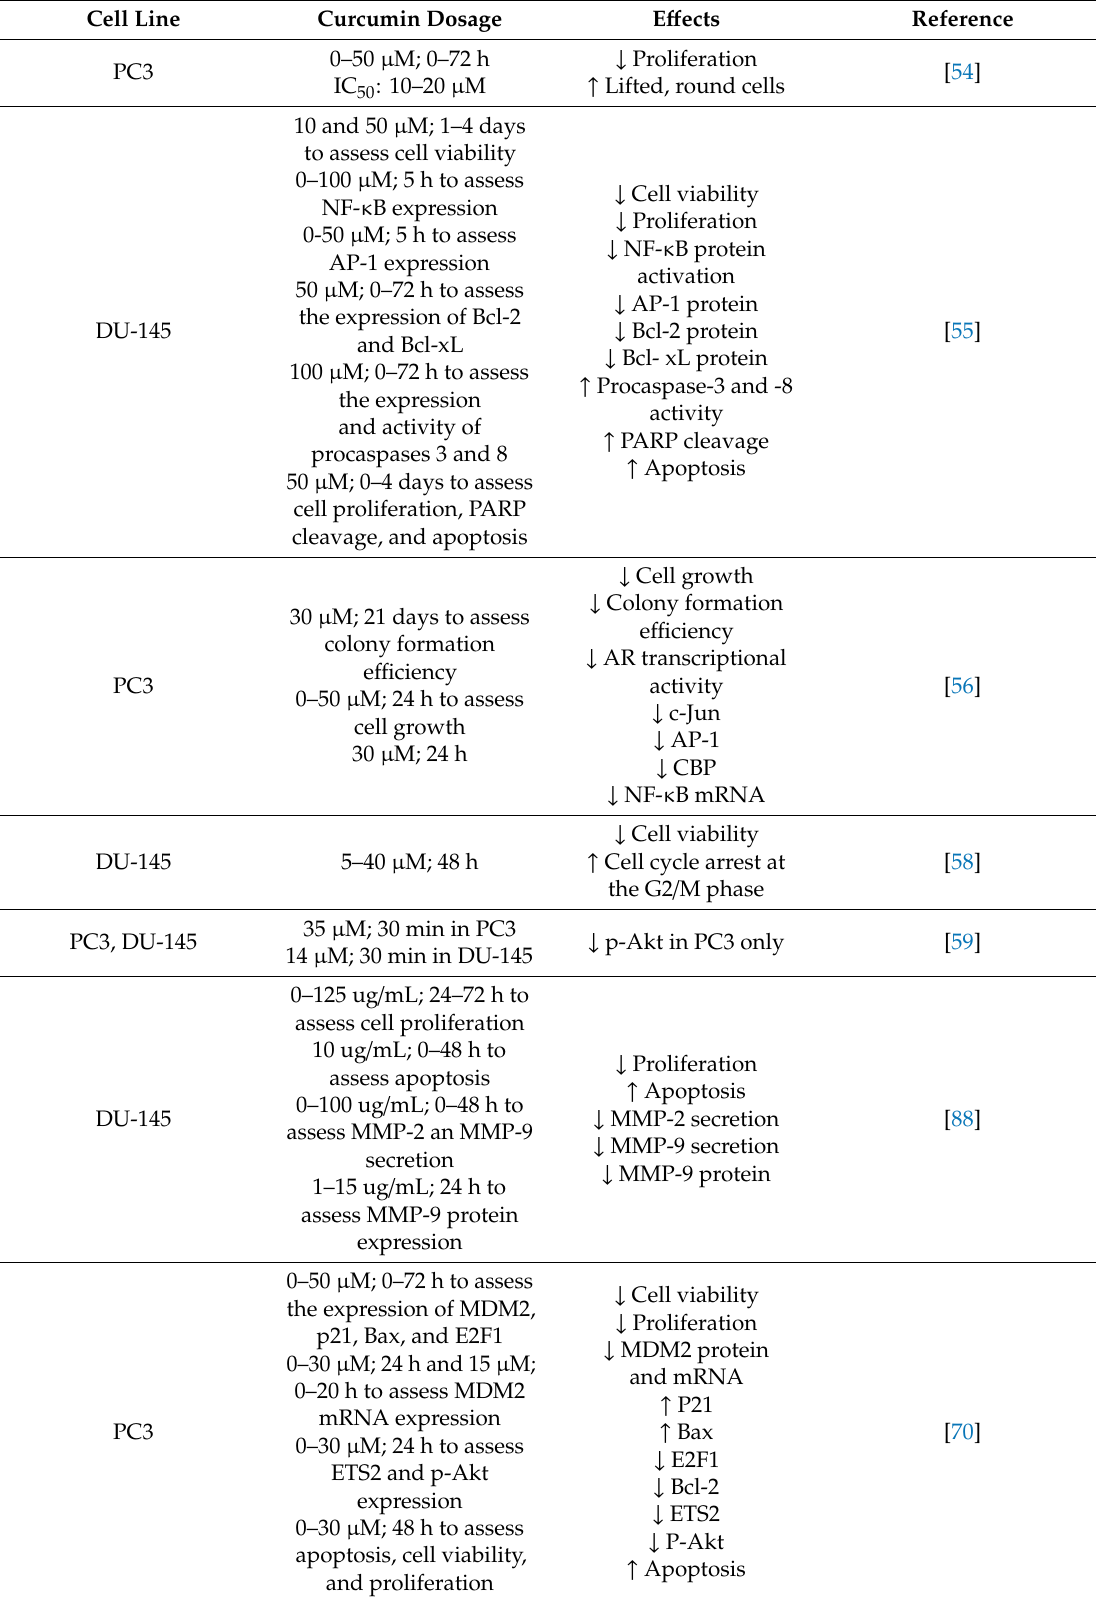
Table 4. In vitro evidence of the e ff ects of curcumin on androgen-insensitive prostate cancer cells. Cell